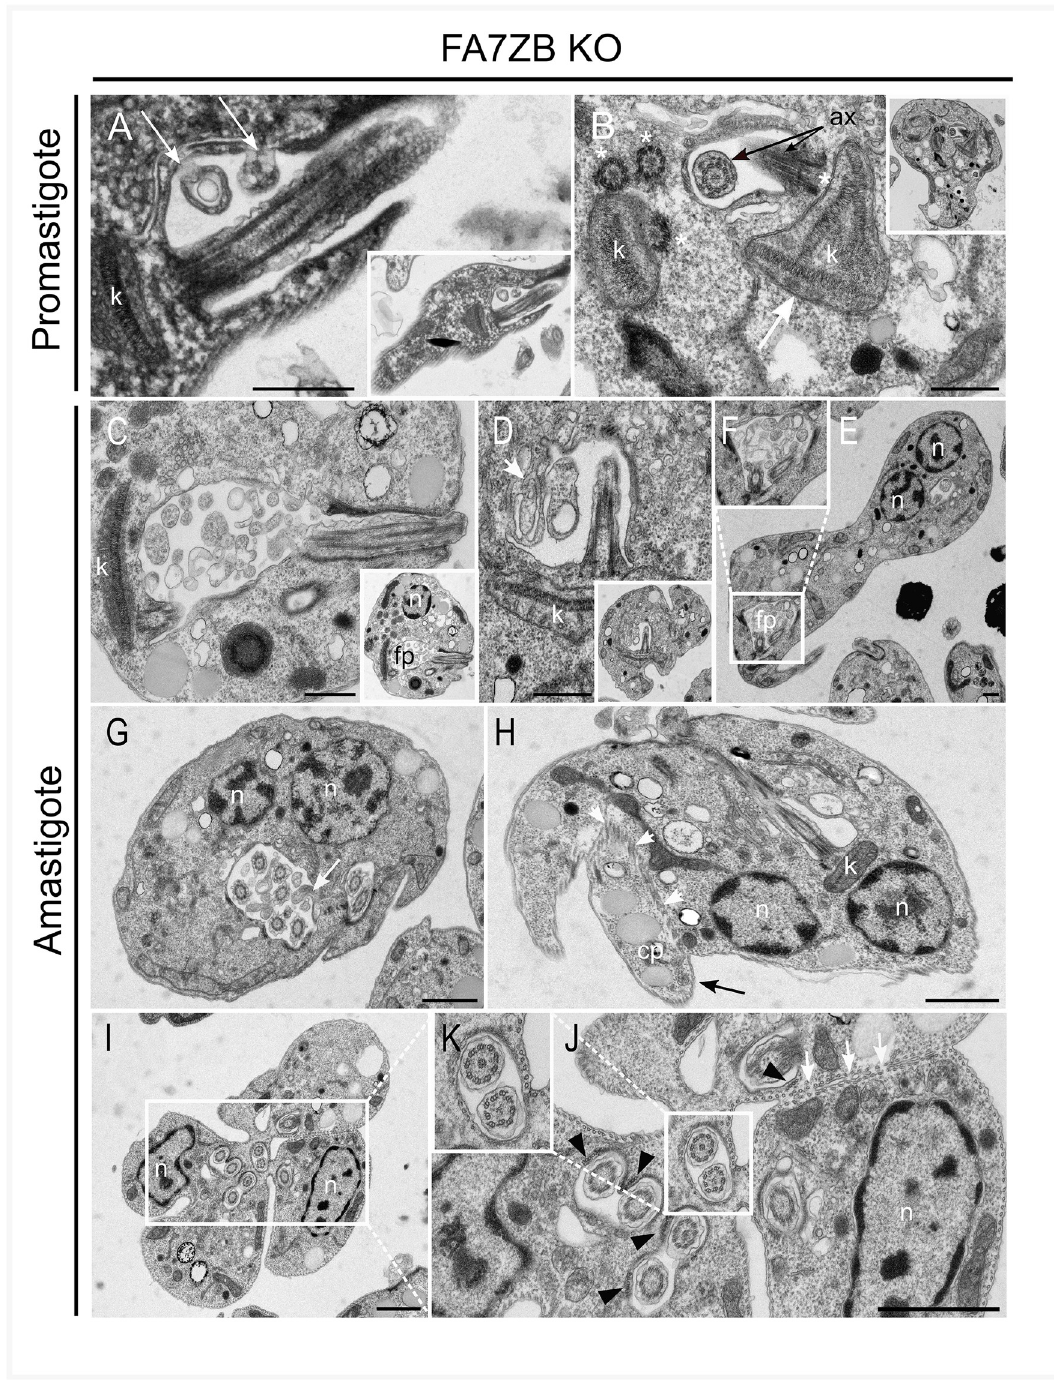
Fig 5. Flagellar pocket structure and cell division are perturbed in the FAZ7B null mutant. Transmission electron micrographs of promastigotes and axenic amastigotes of the FAZ7B KO cell line. Promastigotes (A-B): (A) Abnormal cytoplasmic inclusions are present in the lumen of the FP (white arrows). (B) Rare cells showed abnormal kinetoplasts and/or abnormal basal bodies: here, a mutant cell showing four kDNA networks (of which three are contigous) (white arrow) and four basal bodies asymmetrically distributed (white asterisks). The flagellum structure appears normal (ax, black arrows). Amastigotes (C-K): Abnormal cytoplasmic inclusions were frequently observed in the lumen of the FP (C-G). Depending on the cutting plane, this material could be seen as protrusions of the FP wall inside the lumen of the pocket (D, G; white arrows). (G) An amastigote cell showing two nuclei and six transversal sections of flagella in a single FP and two flagella in another one. (H) Longitudinal section of a dividing amastigote,